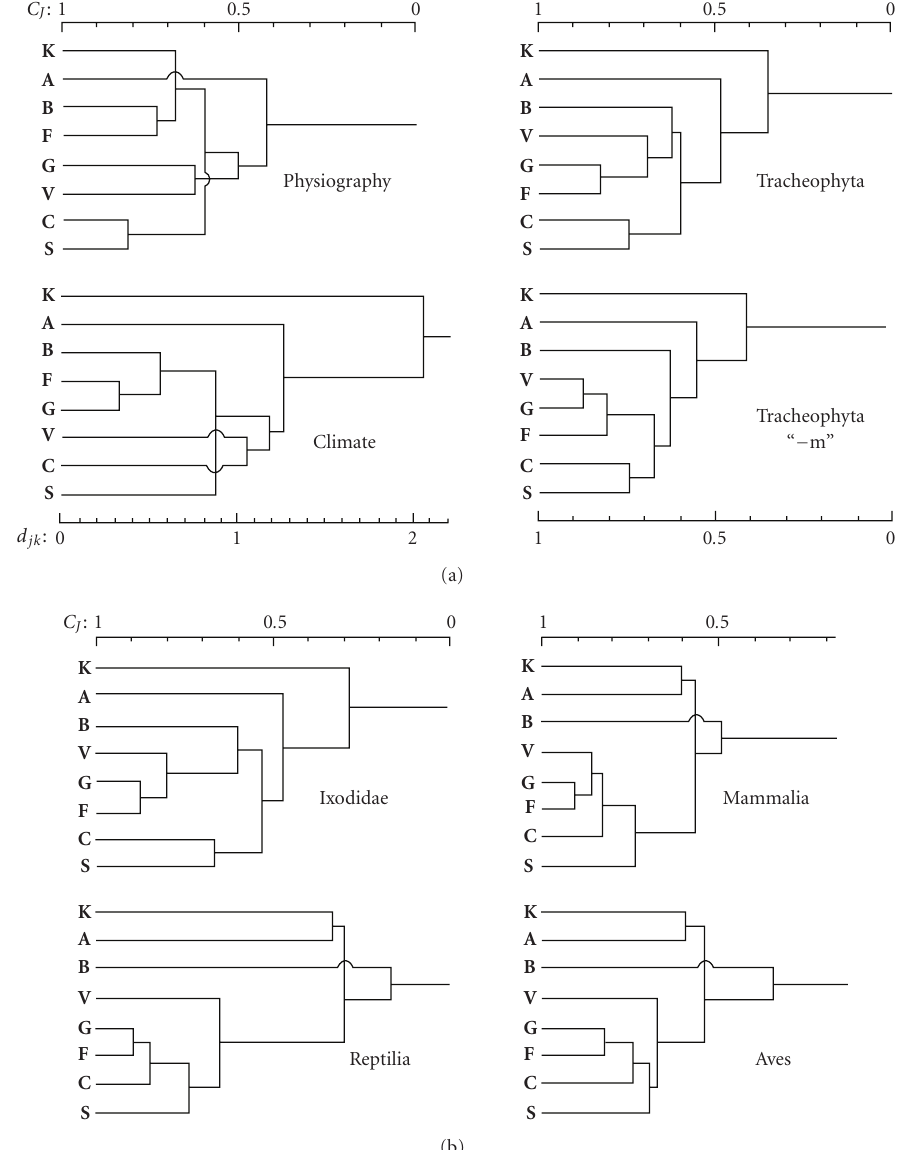
Figure 6: Dendrograms of similarity of the eight Bhanja virus areas in Europe, based on Jaccard coe ffi cient ( C J ) or Euclidean distance ( d jk — climate), and cluster analysis of the values. (a) Physiographic, climatic, and floral similarity; “ − m,” Eumediterranean plus maritime littoral plant species were omitted (b) Faunal (ixodid and vertebrate)